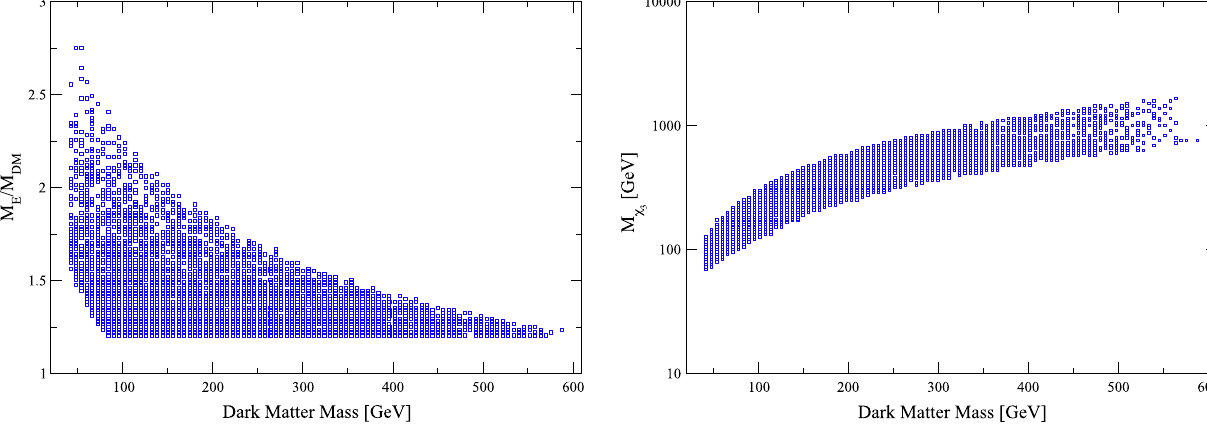
). The relic density constraint favors a χ 1 not much heavier than the dark matter 1 ). Notice that the heaviest odd fermion, χ 3 , rarely has a mass above 1 3